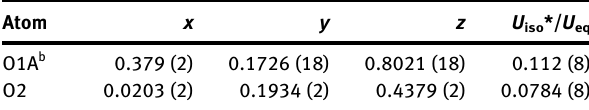
Table  : Fractional atomic coordinates and isotropic or equivalent isotropic displacement parameters (Å 